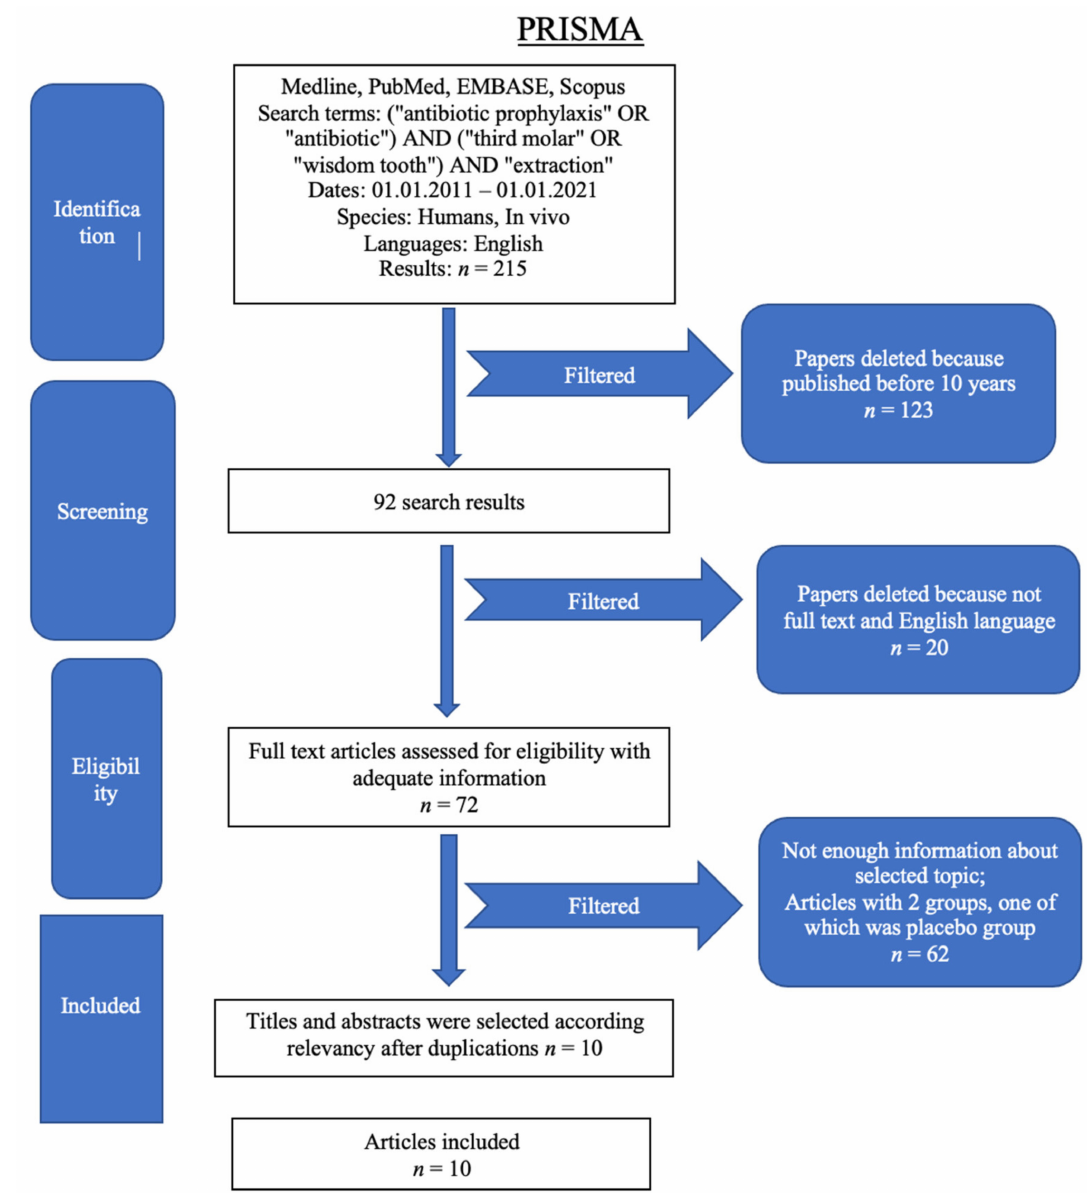
Figure 1. Flow diagram describing the selection process according to the Preferred Reporting Items for Systematic Reviews and Meta-Analyses (PRISMA) recommendations